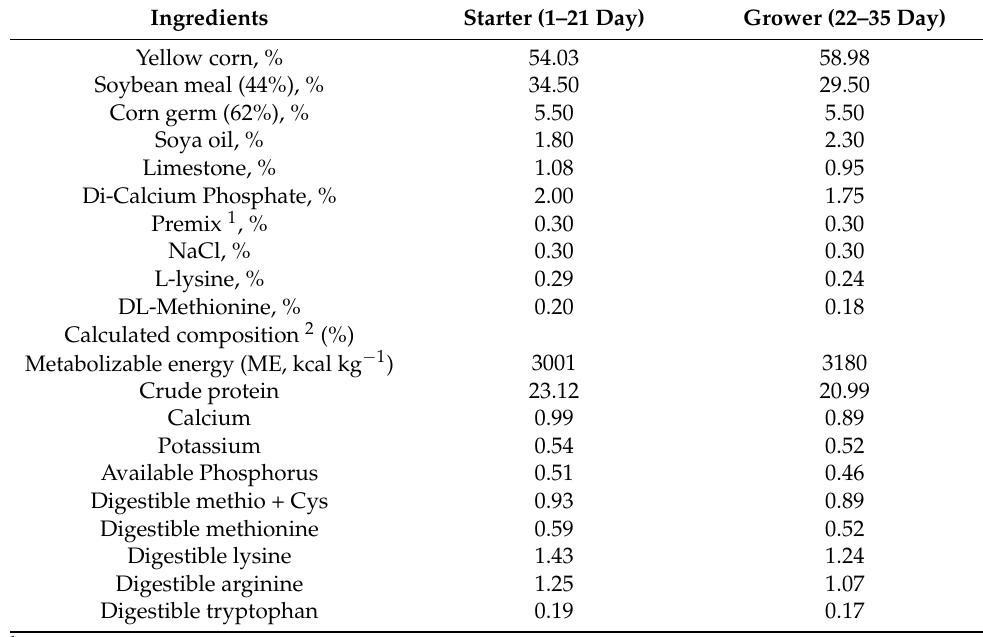
Table 1. Ingredients and calculated chemical composition of the basal